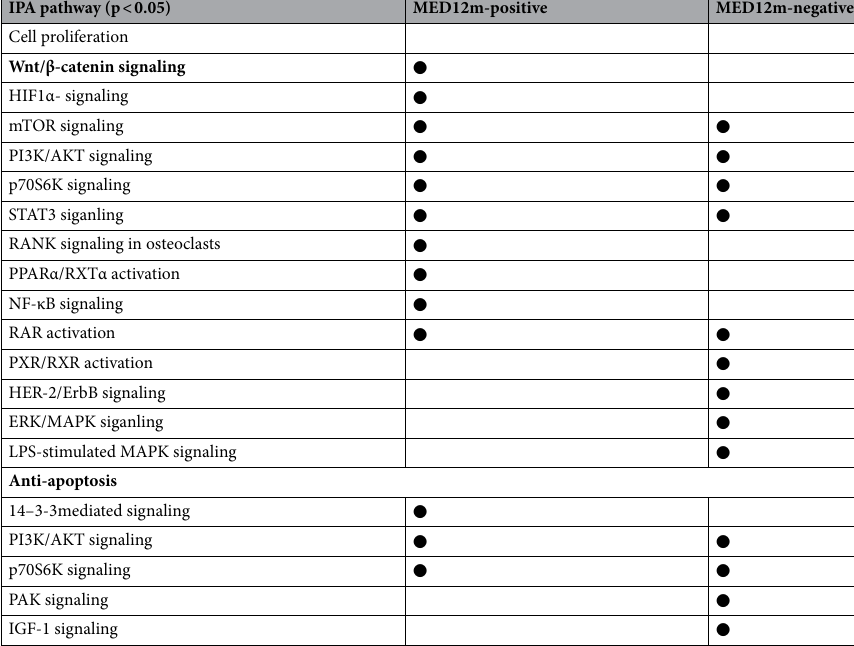
Table 2. Activated signalings of cell proliferation and anti-apoptosis in differentially expressed genes in uterine fibroids. Differentially expressed genes compared to the myometrium (the DEGs) in the MED12m- positive and -negative uterine fibroids were applied to KEGG pathway analysis in IPA, respectively. Detected pathways with p < 0.05 were considered significant enrichment. Activated signaling pathways related to cell proliferation and anti-apoptosis were indicated.